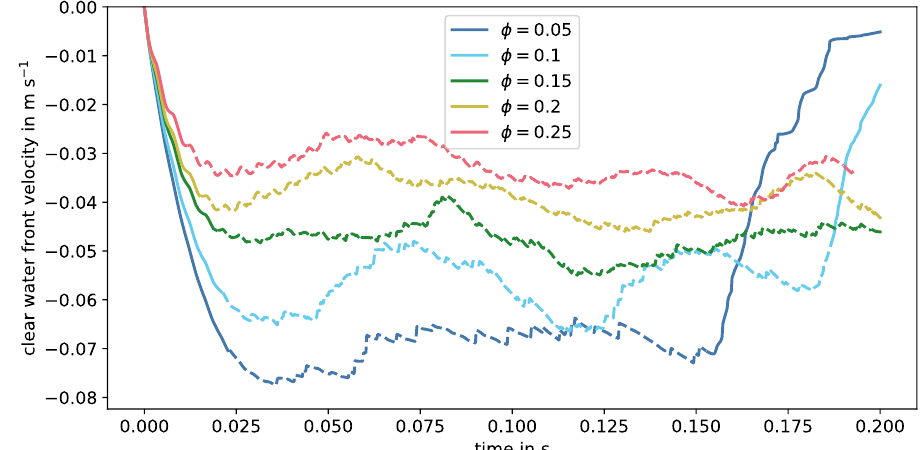
Figure 12. Averages over the settling velocity of the top 5% of particles for various φ and Re = 49.64. The part used for temporal averaging is depicted as dashed line.